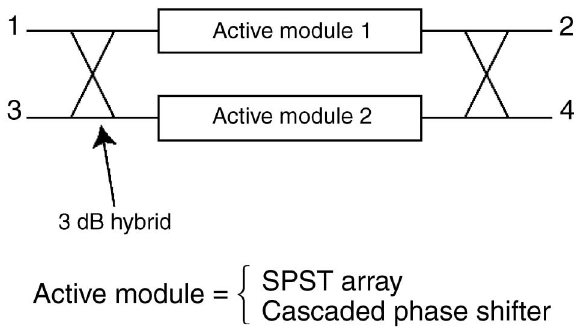
FIG. 1. Schematic diagram of the switch system.